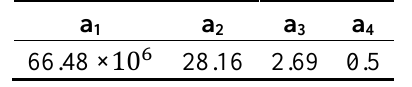
Table 5. Values of the constants for CO prediction